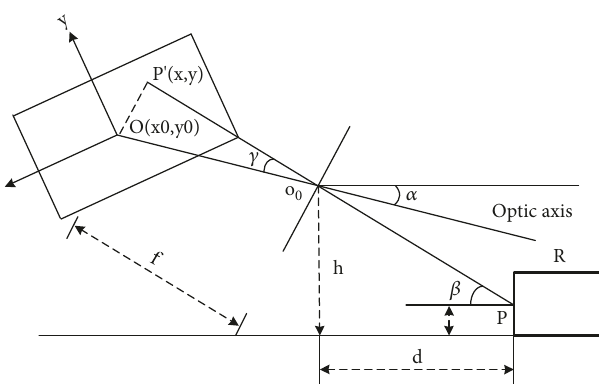
Figure 10: Schematic of monocular vision-based distance measure-